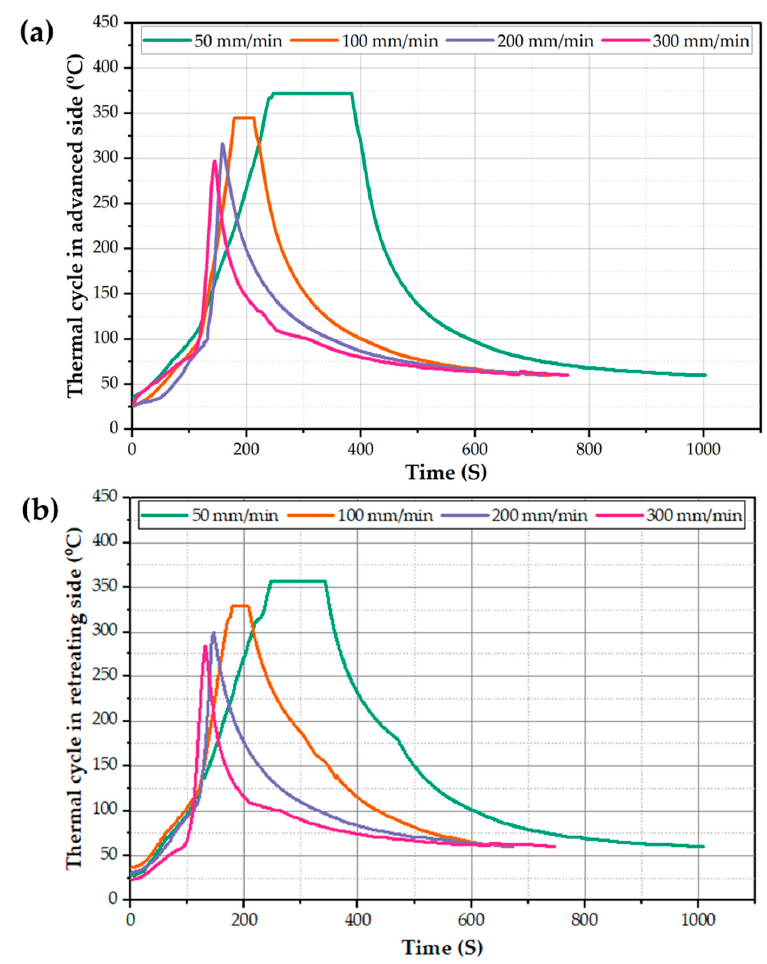
Figure 7. The thermal cycles of the ( a ) AS and ( b ) RS against time for the AA1050 BT-FSPed at a constant rotation speed of 600 rpm and different travel speeds of 50, 100, 200, and 300 mm/min using Cy pin geometry.